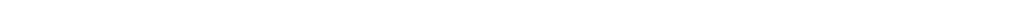
Table 2. Select ChromoPainterV2 calculated parameters for the subgroup 1 vs 2 recombination model (Figure 4). ChromoPainter’s ‘chunkcounts’ parameter is defined as the number of genomic chunks from a population of donor genomes, assigned to the recipient genome via recombination. ‘Chunklengths’ are the combined lengths (in centimorgans X 2 N ) of these chunks. Donor specific mutation rate is the amount of mismatching across the e recipient chunklengths divided by the number of loci. Donor status is the population of donor genomes to which a consensus genome was assigned in the final subgroup 1 vs subgroup 2 recombination model ( Figure 4). To improve recombination models, genomes with high inter-subgroup recombination were iteratively removed from the populations if model quality (as judged by average copy probability) was increasing.